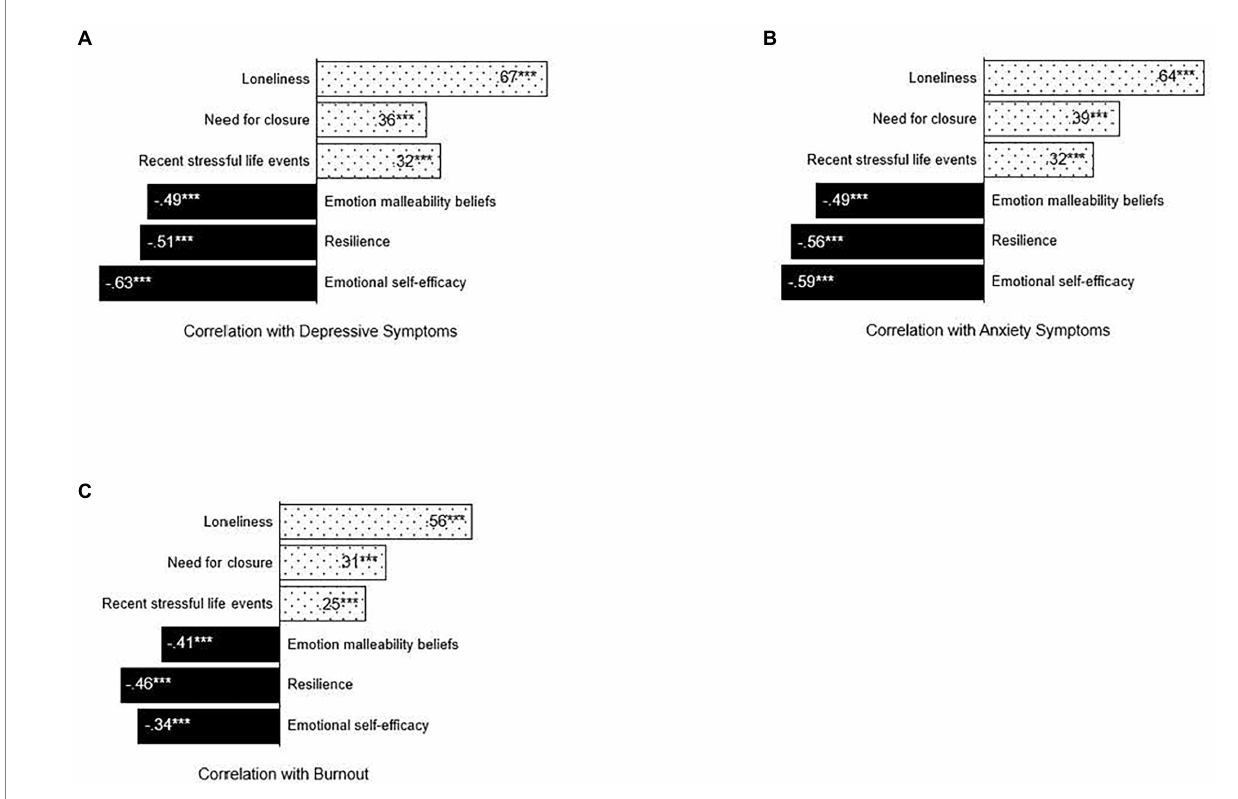
FIGURE 1 Correlations between modifiable protective/risk factors and mental health symptoms and burnout. Zero-order correlations between modifiable protective (solid black)/risk factors (dotted) and (A) depressive symptoms, (B) anxiety symptoms, and (C) burnout. All correlations are greater than zero at p < 0.001. N =